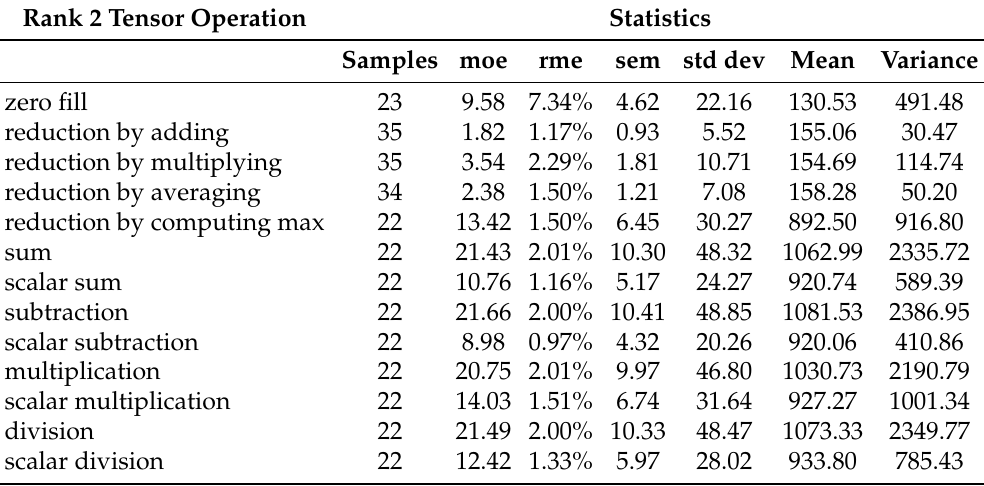
Table 13. Raspberry Pi III B+ benchmark statistics for rank 2 tensor operations with k = 128 (times in ms).